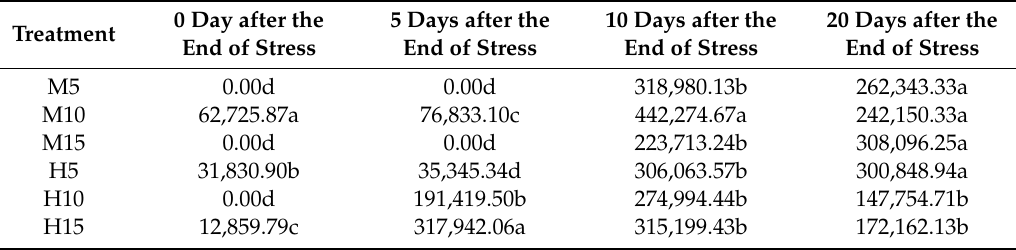
Table 2. Aerenchyma area after exposure to high temperature and waterlogging stress ( µ m 2 ). Treatment